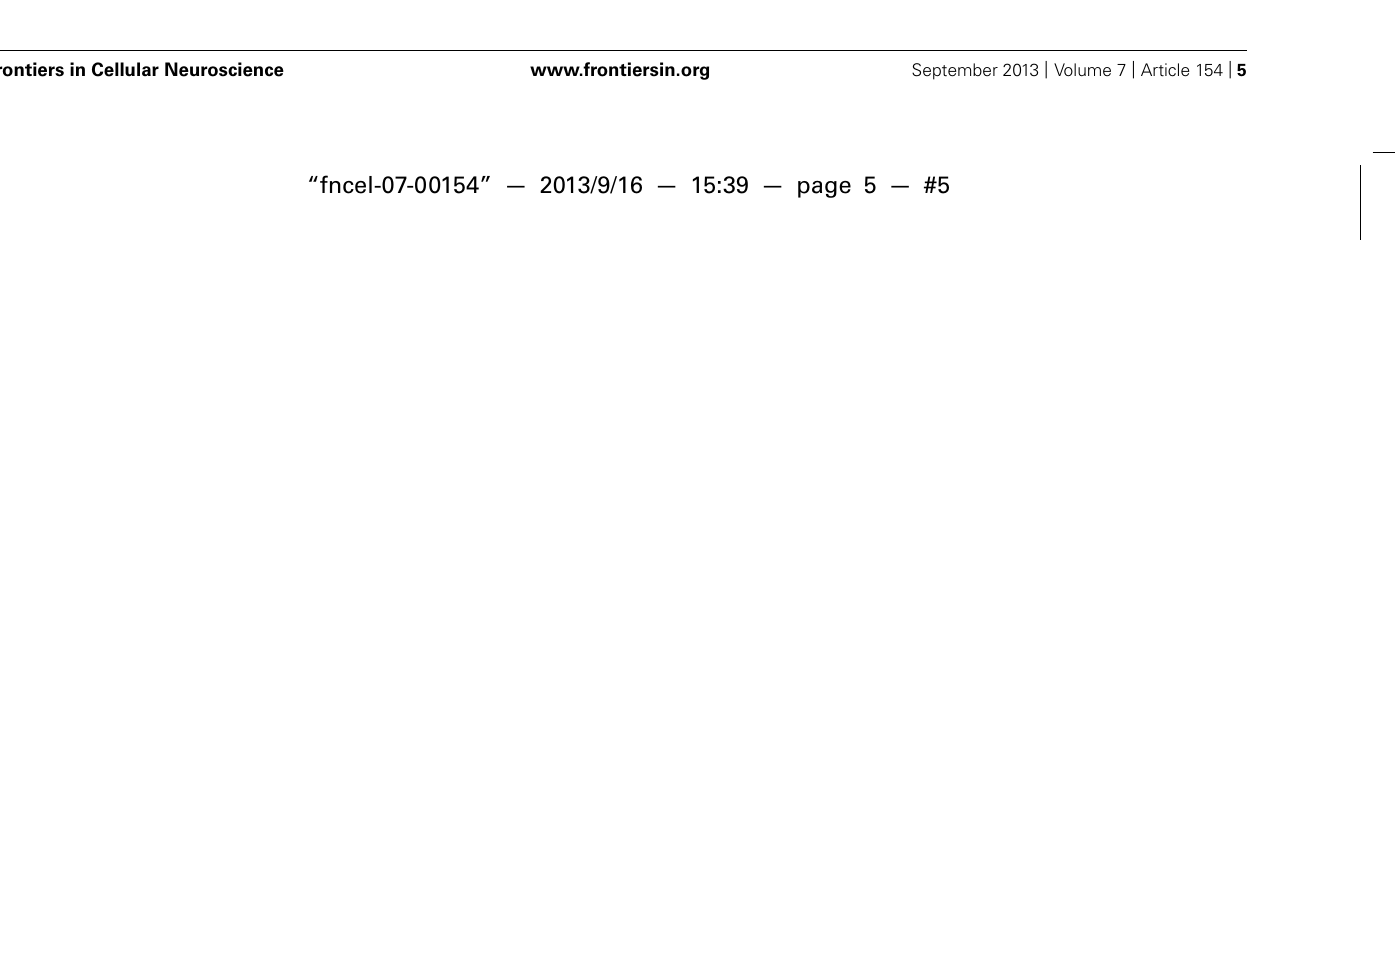
Note an increasing with time number of electrodes revealing paroxysmal discharges. (C) An expanded segment of paroxysmal discharge showing spike and wave pattern (modified from Nita etal.,